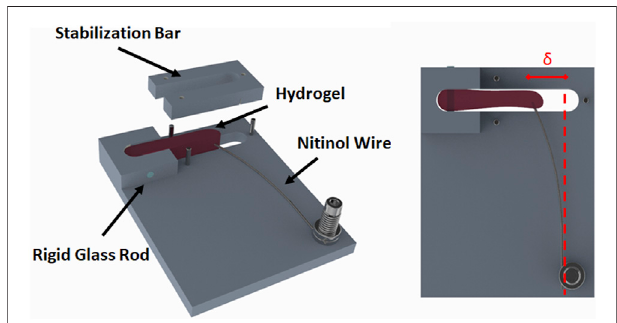
FIGURE 2 | Schematic of the force-bioreactor. A cell seeded fi brin gel (i.e., hydrogel) is polymerized in the cavity containing a rigid glass rod and a bendable Nitinol wire. The stabilization bar is only present during initial gel polymerization. Once polymerized, the stabilization bar is removed, and the hydrogel is free to contract. Force is determined by the amount of de fl ection ( δ ) the contracted gel produces in a calibrated